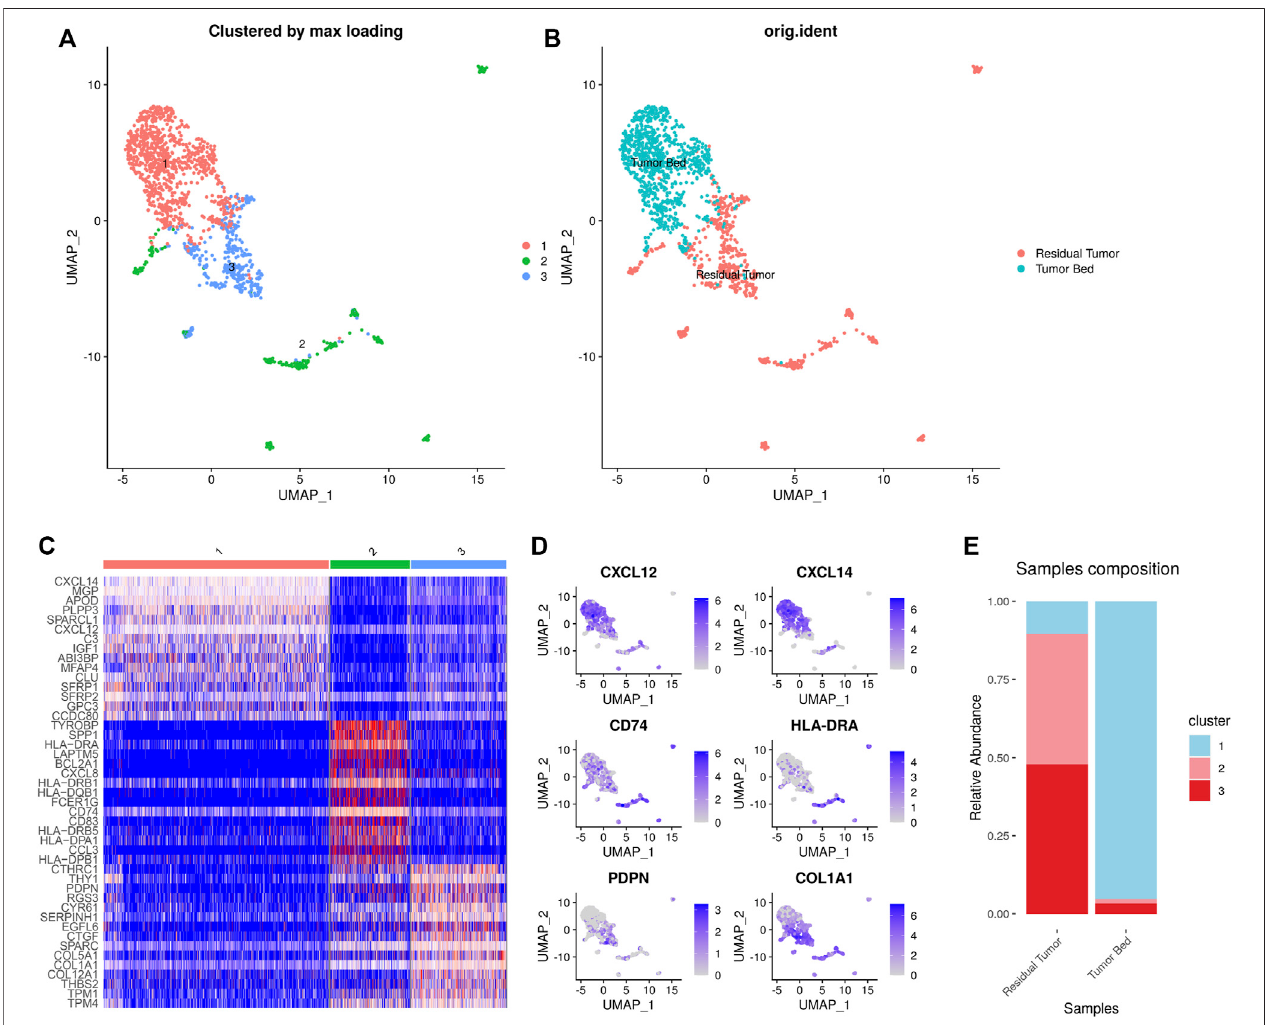
FIGURE 4 | Heterogeneity of CAFs in OSCC after ICT. UMAP plot showing the subclusters divided using NMF (A) and the original ident (B) . Marker genes expression shown inheatmap. C1CAFsexpressed CXCL12, CXCL14, andIGF1. C2CAFsexpressed CD74and MHC- Ⅱ .C3CAFsexpressed PDPNand COL1A1 (C) . FeatureplotsshowingCXCL12,CXCL14,CD74,HLA-DRA,PDPN,COL1A1expressioninCAFs (D) .Theproportionofsubclustersinresidualtumorandtumorbed.C1 CAFs were mainly enriched in tumor bed and C2 and C3 CAFs were enriched in residual tumor (E) .